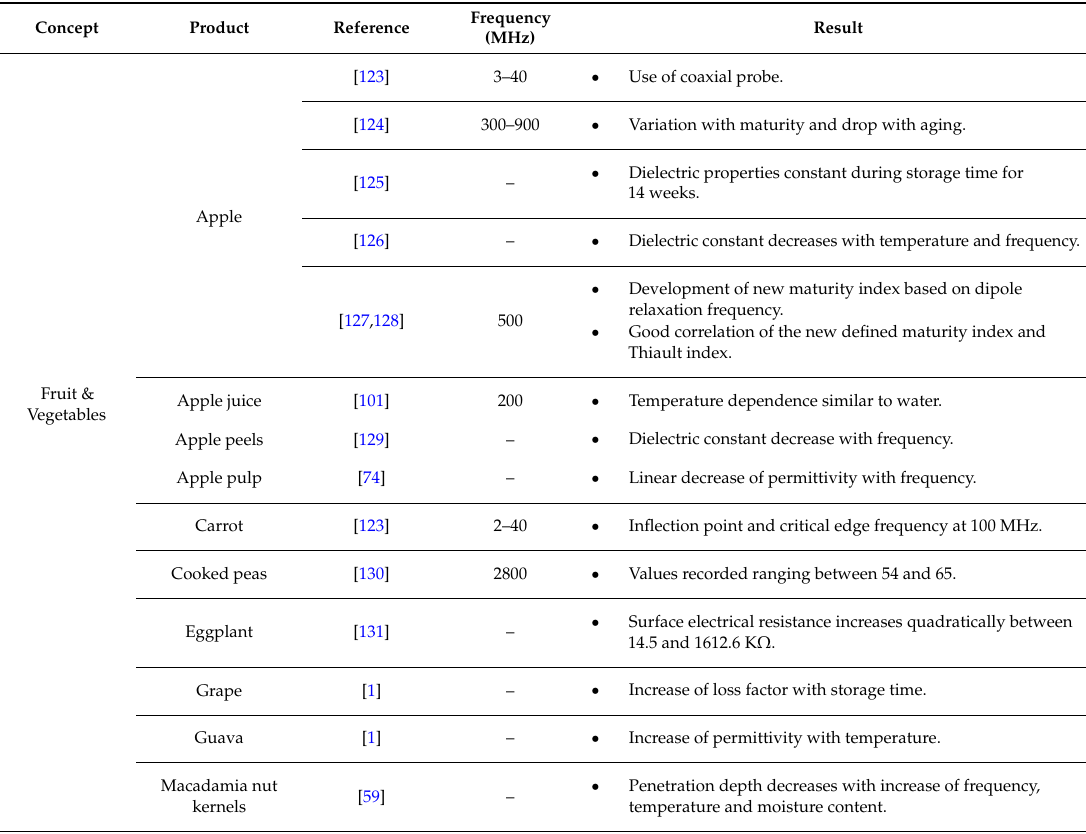
Table 2. Experiments executed on various food products for dielectric property